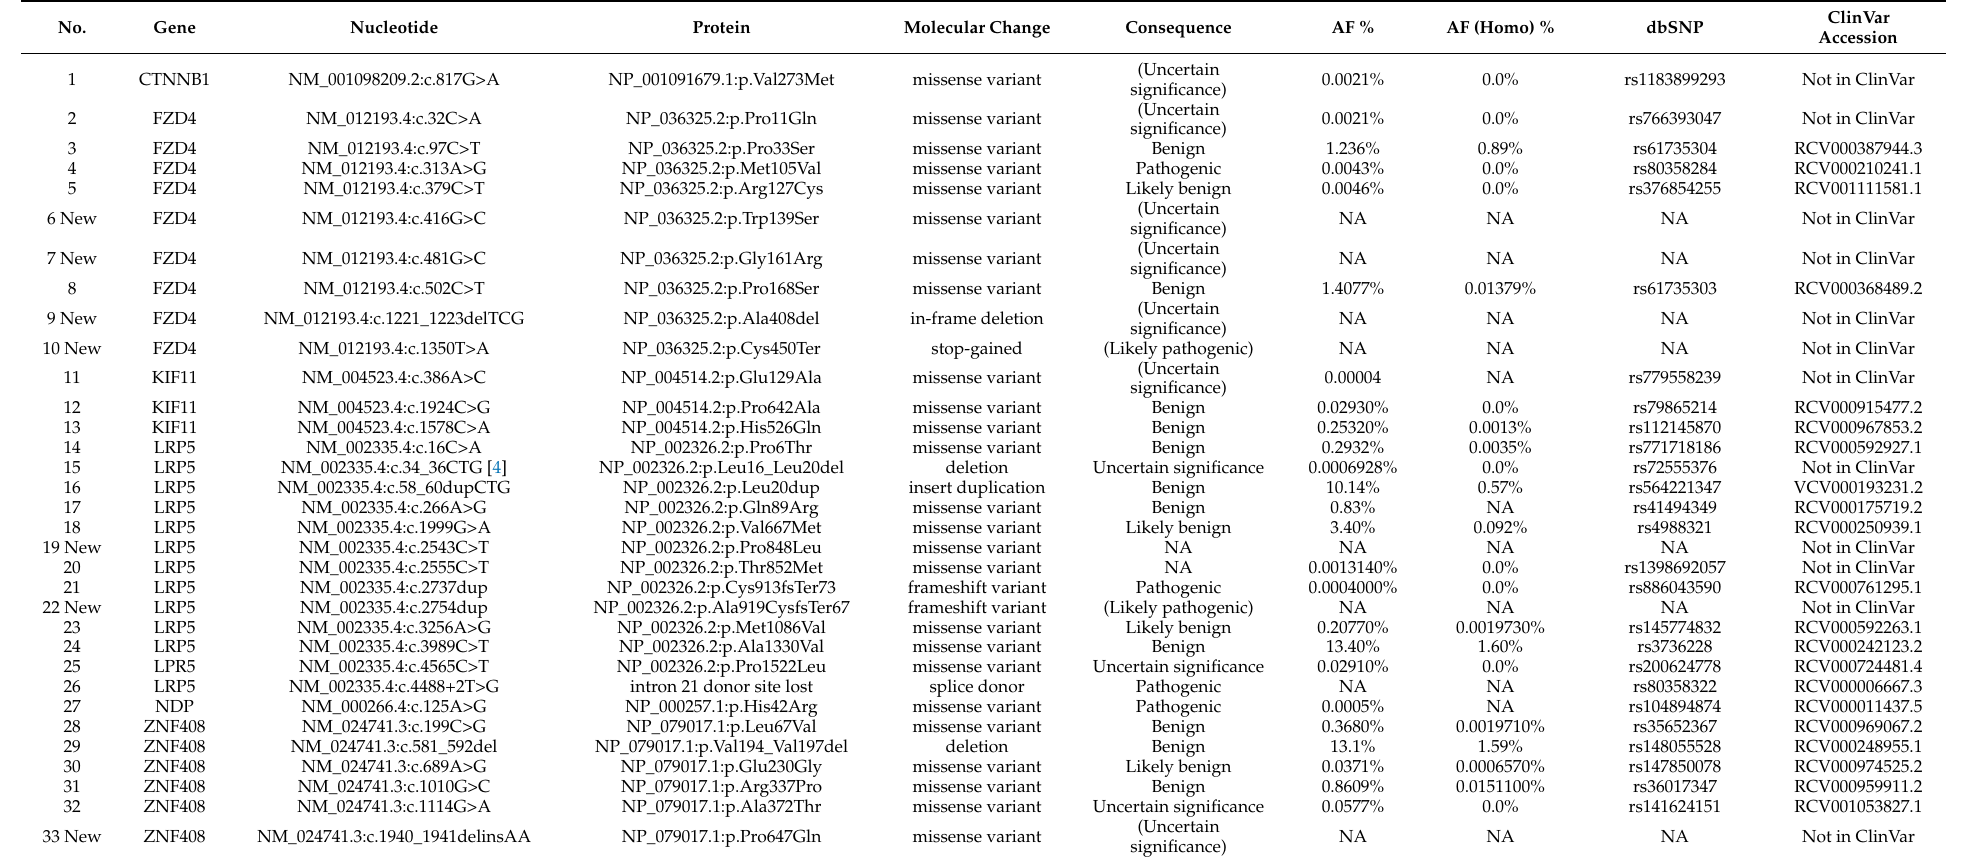
Table 4. Variants altering the primary amino acid sequence. For six of the seven FEVR genes sequenced ( NDP , CTNNB1 , KIF11 , FZD4 , LRP5 , ZNF408 ), thirty-three variants were detected that alter the primary amino acid sequence. Only synonymous variants were found in TSPAN12 . Seven new variants are noted, including a likely pathogenic Cys450Ter stop-gained variant in FZD4. Allele Frequency (AF %) was derived from GnomDB. Accession numbers in dbSNP and ClinVar are shown where available. Consequence categories were from ClinVar, except those listed in parentheses, which are the current determinations of the